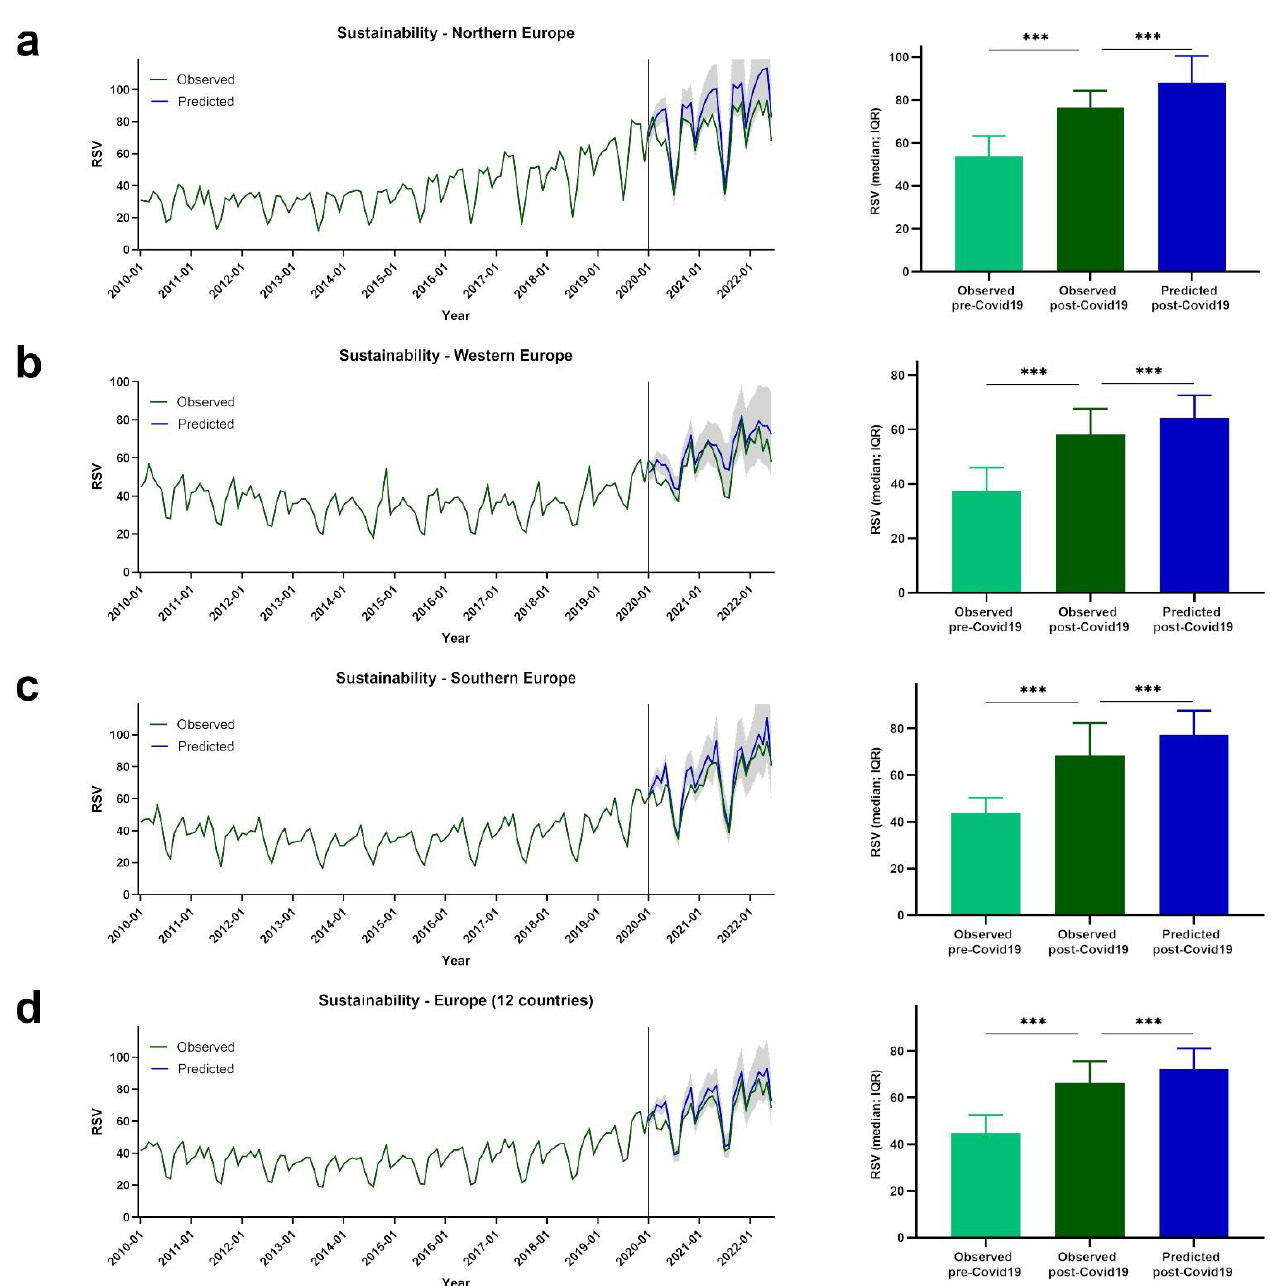
Figure 2. The RSV evolution for Sustainability topic. ( a ) Evolution of RSVs for Sustainability topic in northern Europe from January 2010 to June 2022 (green line), predicted evolution of RSVs for Sustainability topic between January 2020 and June 2022 (blue line); gray shadow represents 95% confidence interval. ( b ) Evolution of RSVs for Sustainability topic in western Europe from January 2010 to June 2022 (green line), predicted evolution of RSVs for Sustainability topic between January 2020 and June 2022 (blue line); gray shadow represents 95% confidence interval. ( c ) Evolution of RSVs for Sustainability topic in southern Europe from January 2010 to June 2022 (green line), predicted evolution of RSVs for Sustainability topic between January 2020 and June 2022 (blue line); gray shadow represents 95% confidence interval. ( d ) Evolution of RSVs for Sustainability topic in Europe from January 2010 to June 2022 (green line), predicted evolution of RSVs for Sustainability topic between January 2020 and June 2022 (blue line); gray shadow represents 95% confidence interval. For ( a – d ) bars represent the comparison between median RSVs pre-COVID-19 and post-COVID-19, and between post-COVID-19 and predicted post-COVID-19 data. *** p < 0.001.